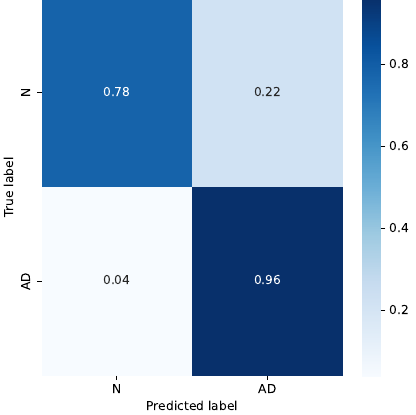
Figure 8. Confusion matrix for a sample